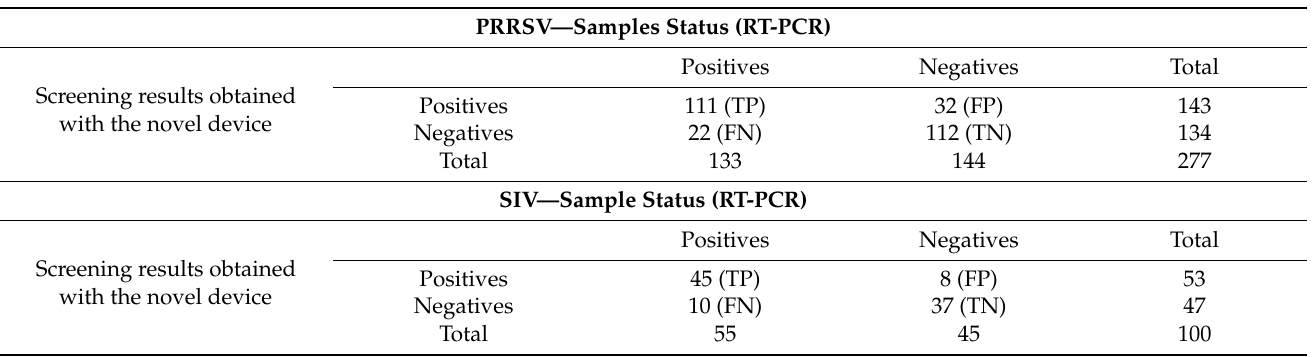
Table 3. The screening results for PRRSV and SIV obtained with the novel POC device versus the RT-PCR results. The number of TP, TN, FP, and FN for each sensor type are presented. PRRSV—Samples Status (RT-PCR)